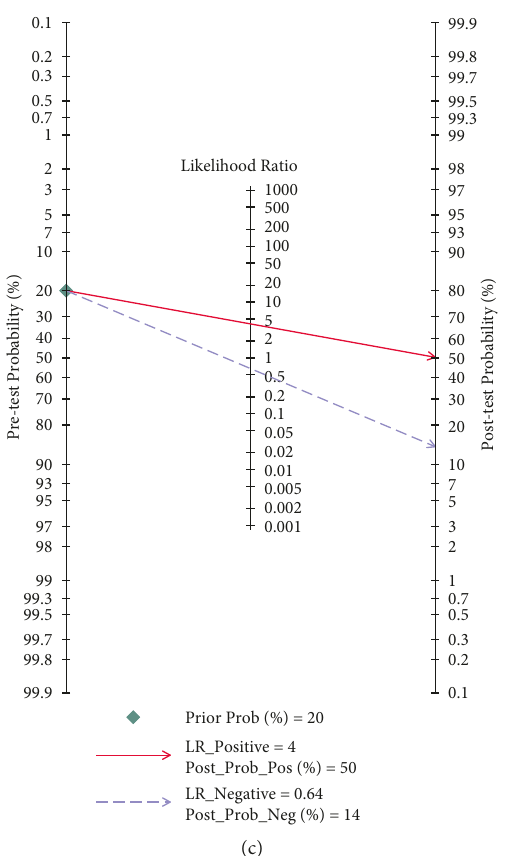
Figure 3: The forest plot of the (a) sensitivity and specificity of qSOFA, (b) the summary receiver operating curve of qSOFA, and (c) pre- and posttest probability of qSOFA for patients in the